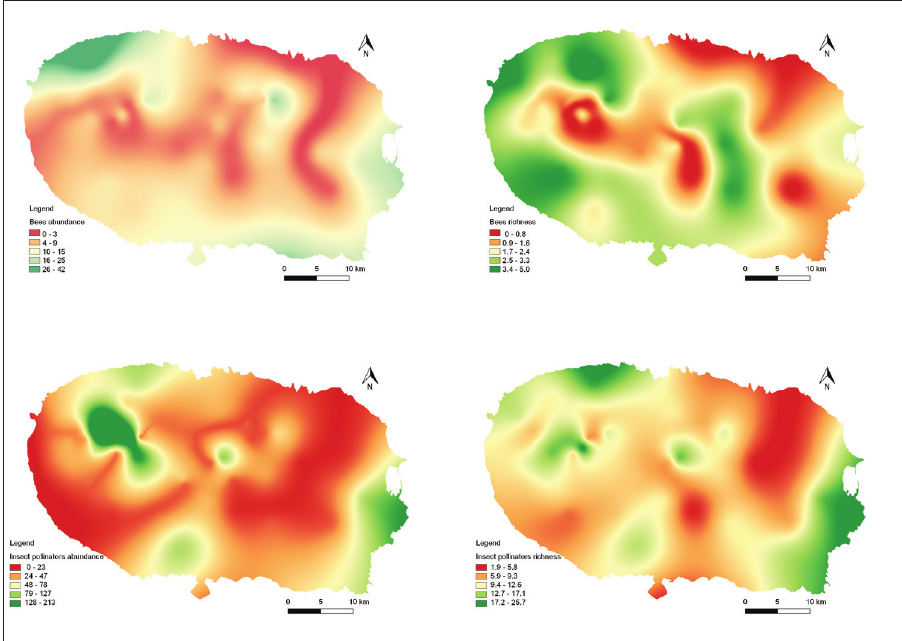
Figure 2. Pollination services’ interpolation maps: (upper left) bees abundance (N); (upper right) bees richness (S); (lower left) insect pollinators abundance (N); (lower right) insect pollinators richness